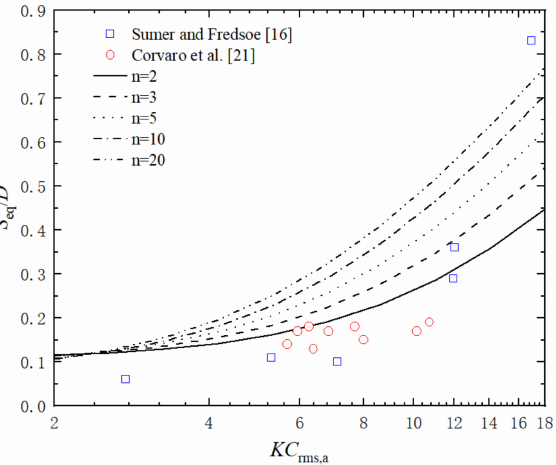
Figure 21. Comparison of S eq between the experimental results of Sumer and Fredsøe [16] and Corvaro et al. [21] and the predicting values by Equation